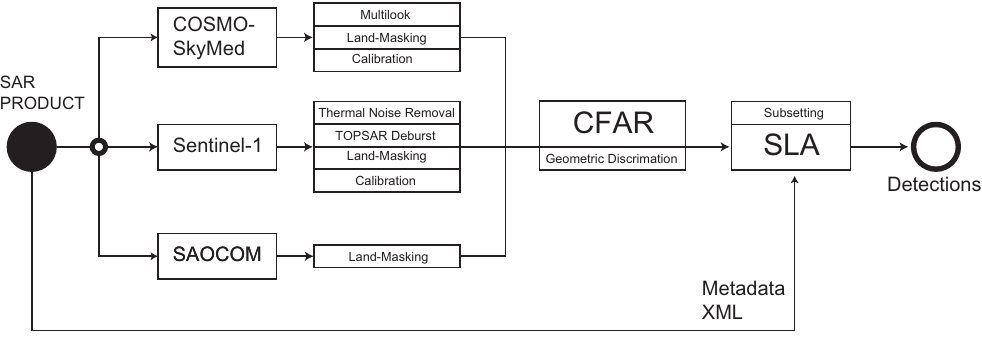
Figure 4. Complete processing flow of the CFAR and SLA